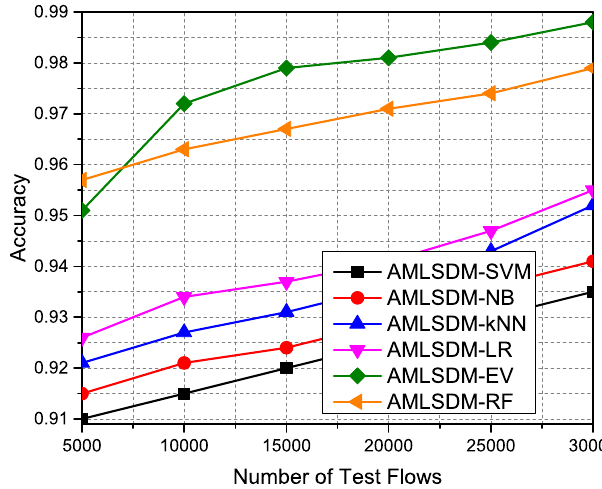
Figure 23. Accuracy performance of ML